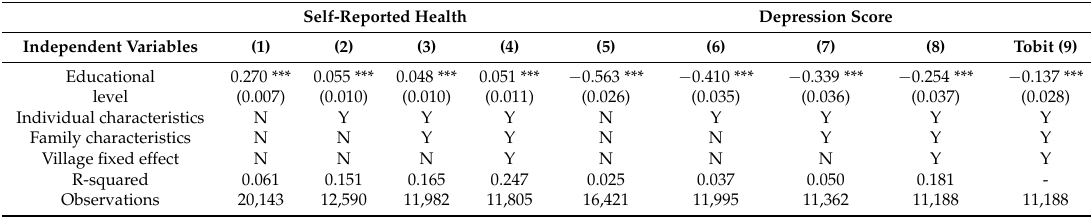
Table 3. The impact of education on health